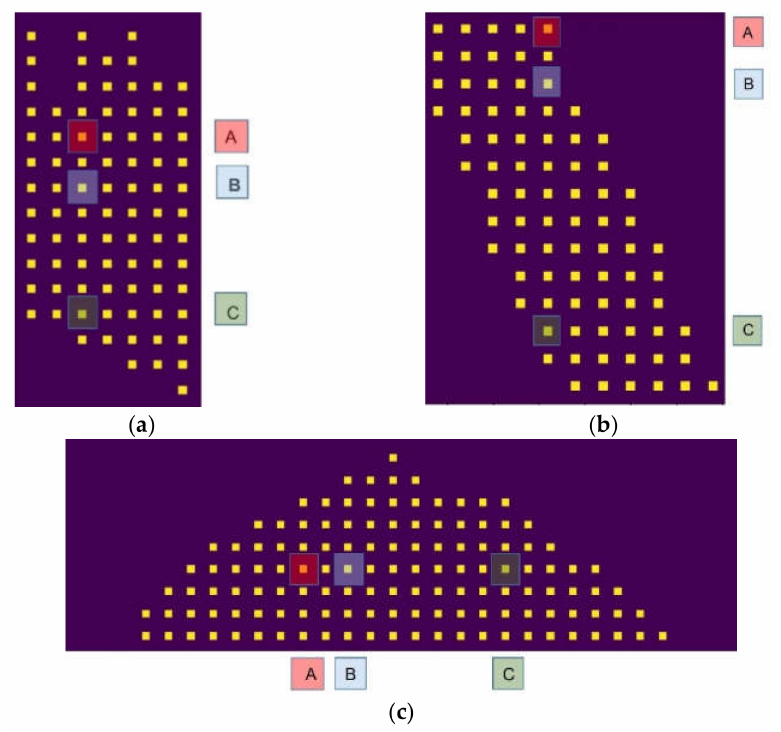
Figure 11. Examples of the sample distributions for the training set, when the distance between the selected samples is set to a window size w = 3, for: ( a ) a class in the Indian Pines dataset, ( b ) a class in the Pavia University dataset, ( c ) a class in the Salinas dataset.